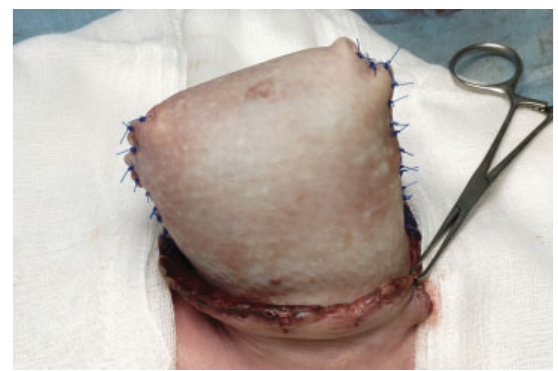
Fig. 1 Completed suturing of the fascia to the porcine-derived acellular dermal matrix (14th day after birth).